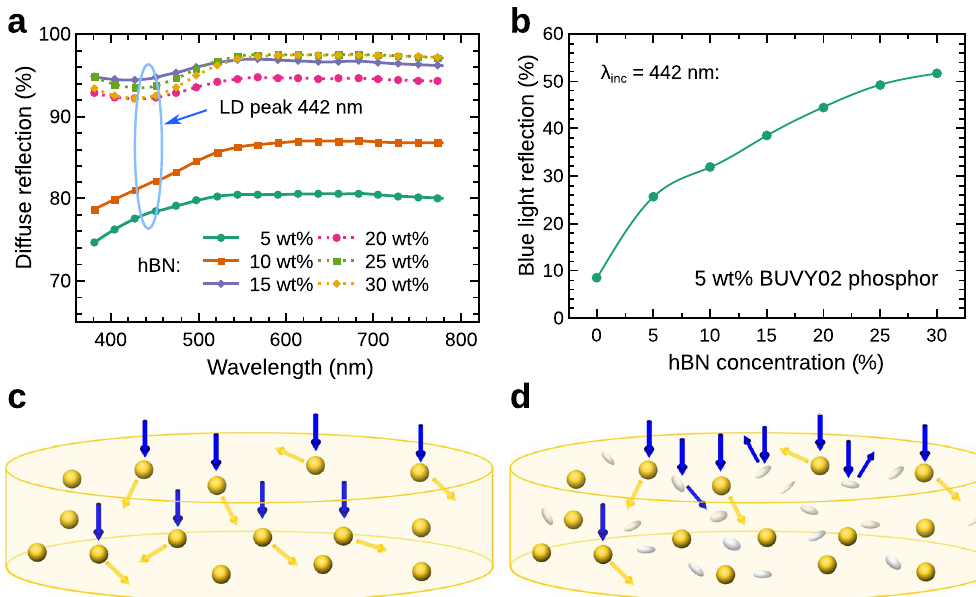
Figure 3. Light reflection mechanism of phosphor-silicone converters. ( a ) The diffuse reflection spectra of silicone converter matrices containing no phosphor for different hBN particle concentrations. The blue ellipse highlights the LD emission peak wavelength. ( b ) The dependence of the LD emission light (442 nm) reflection on the hBN concentration in the phosphor-silicone converter containing 5 wt% of BUVY02 phosphor. ( c ) and ( d ) The excitation of phosphor particles (yellow spheres) in the converter in the absence and presence of hBN particles (white ellipsoids), respectively. Blue arrows correspond to the excitation light, and yellow ones to the phosphor